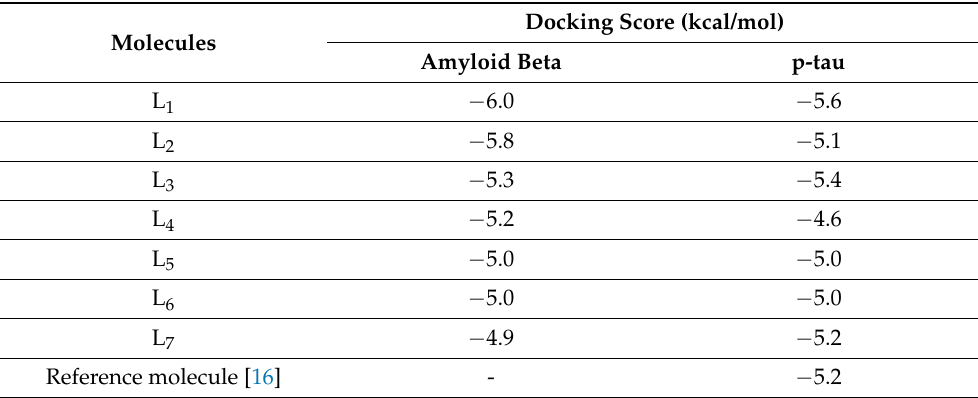
Table 3. The molecular docking scores of L 1–7 with A β and p-tau.